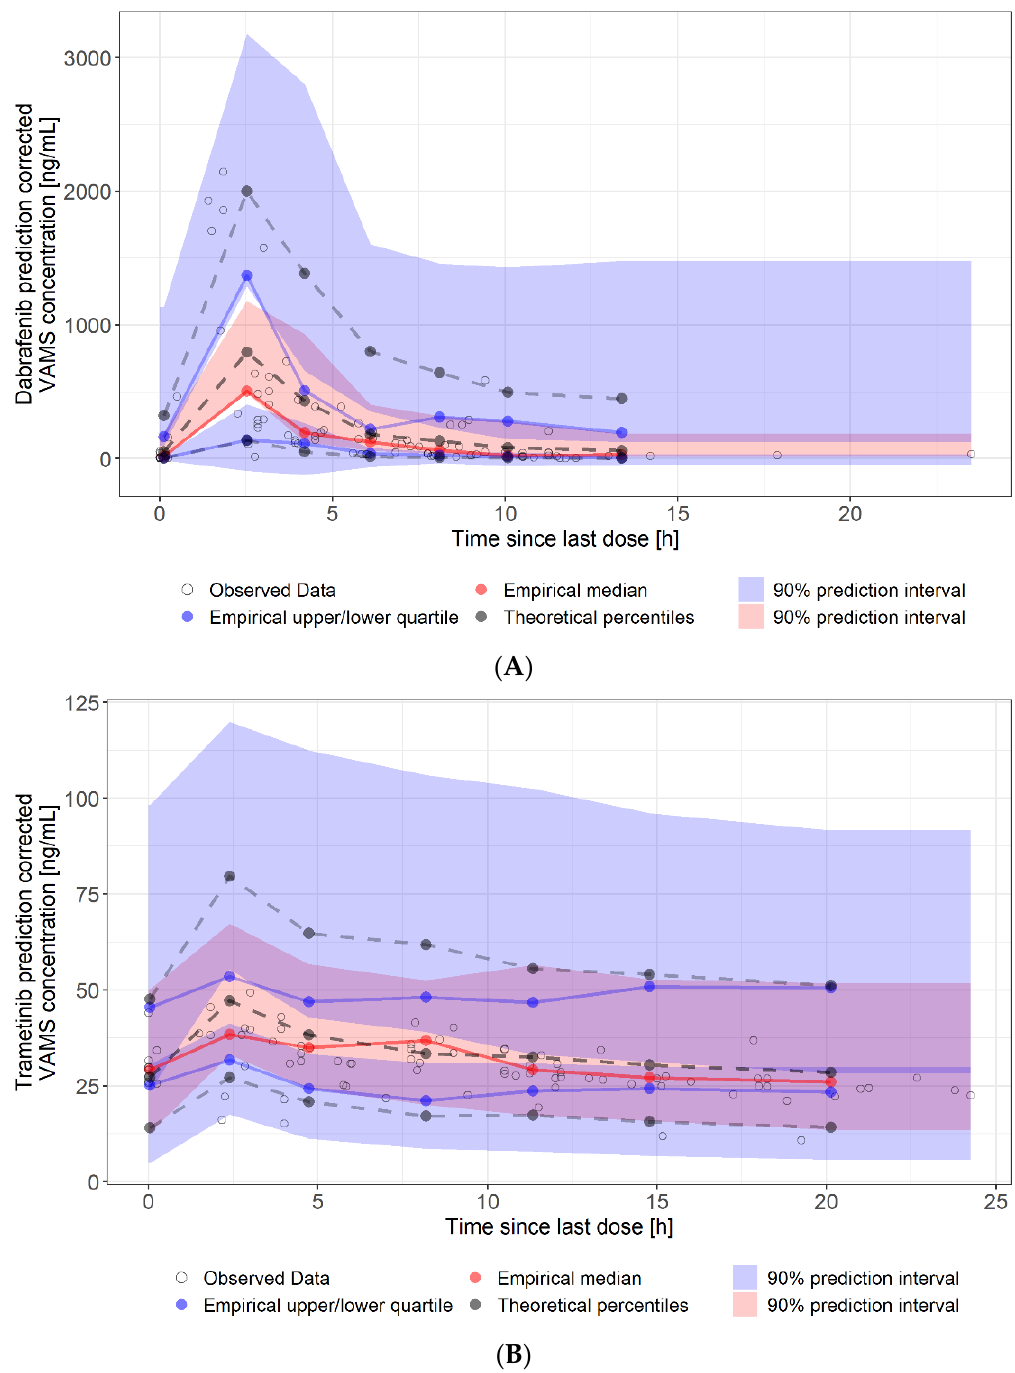
Figure 4. Visual predictive check of at-home sampled VAMS concentrations. ( A ): dabrafenib VAMS concentrations (90 samples, eight patients). ( B ): trametinib VAMS concentrations (84 samples, seven patients). Solid lines represent the 5th (lower blue), 50th (red), and 95th (upper blue) percentiles of the observed data. Shaded regions represent the 90% confidence intervals surrounding the 5th, 50th, and 95th percentiles from the predicted data. The plot demonstrates that the model predictions captured the majority of observed dabrafenib and trametinib concentrations within the 5th and 95th percentiles of the simulated values. Table 2. MAP estimates for dabrafenib serum pharmacokinetic parameters using at-home sampled VAMS.